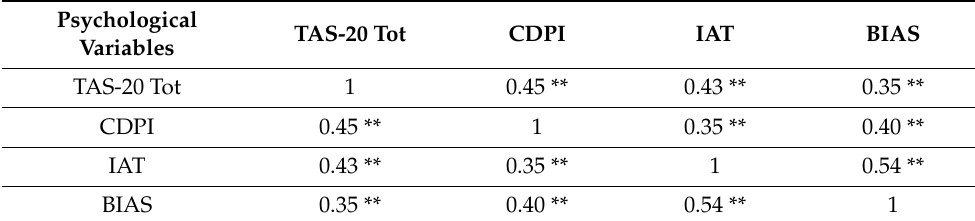
Table 5. Pearson’s correlation analyses between emerging adults’ scores on TAS-20, CDPI, IAT, and BIAS.